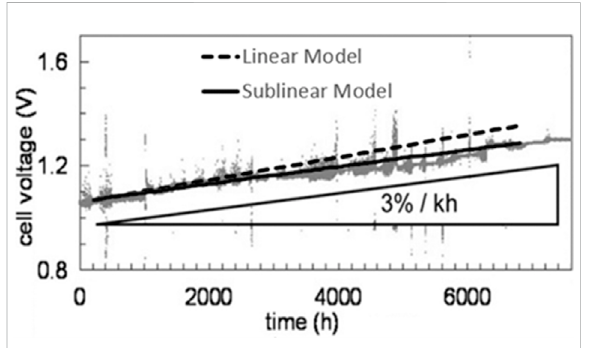
FIGURE 3 Results of the simulation of long-term performance degradation in SOEC using the linear and sublinear models compared to experimental data from (Tietz et al., 2013). Our linear and sublinear models are drawn as dashed and solid lines, respectively, on amodi fi edversion oforiginal fi gure. Figure reused with permission from (Naeini et al.,